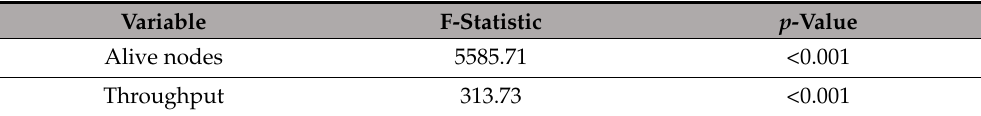
Table 6. The results of the ANOVA